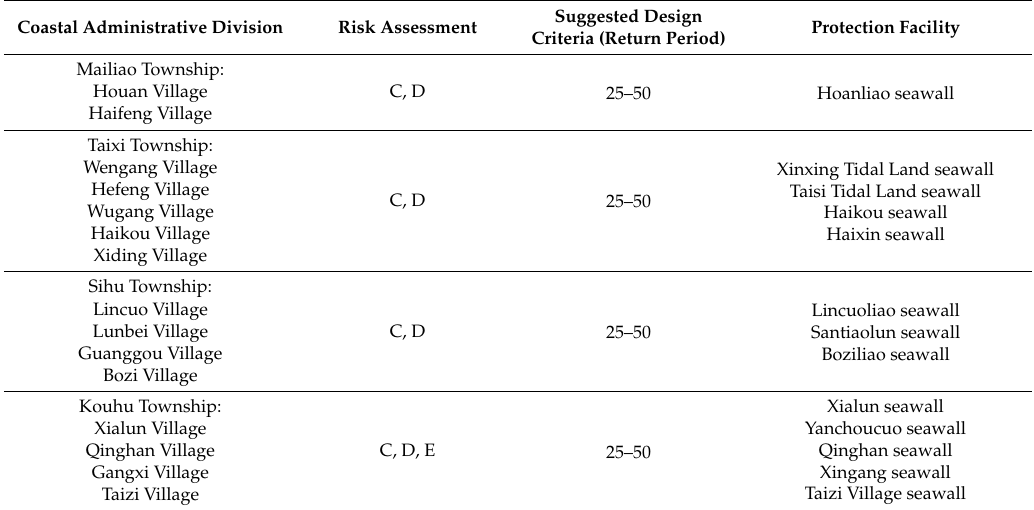
Table 4. Risk level assessment and suggested design criteria in Yunlin County.